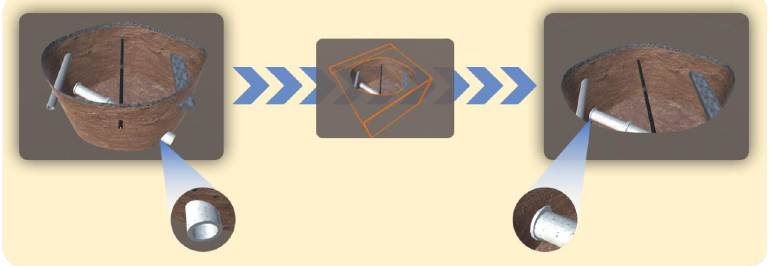
Figure 6. Occlusion for pipelines and walls.